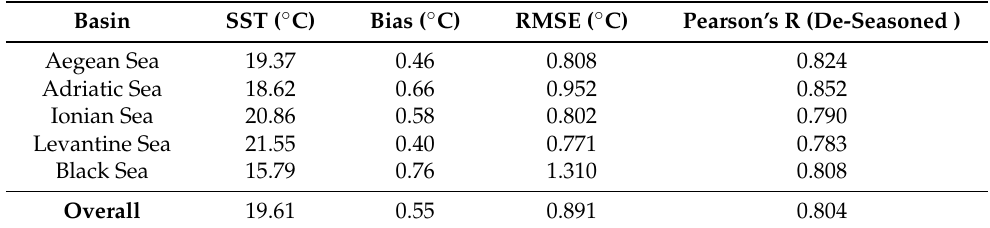
Figure 3. Time-averaged SST for the whole simulation period (1985–2014). ( a ) simulated, ( b ) bias from satellite (EMBS − AVHRR), ( c ) RMSE, and ( d ) Pearson’s R-coefficient for the deseasoned timeseries. All values in degrees Celsius. Table 2. Mean SST from the EMBS-simulation along with metrics of the comparison with satellite reanalysis, for different basins. The Pearson’s R-coeff. is only shown for the deseasoned signal while being statistically significant for all individual grid points in the domain ( p -value <